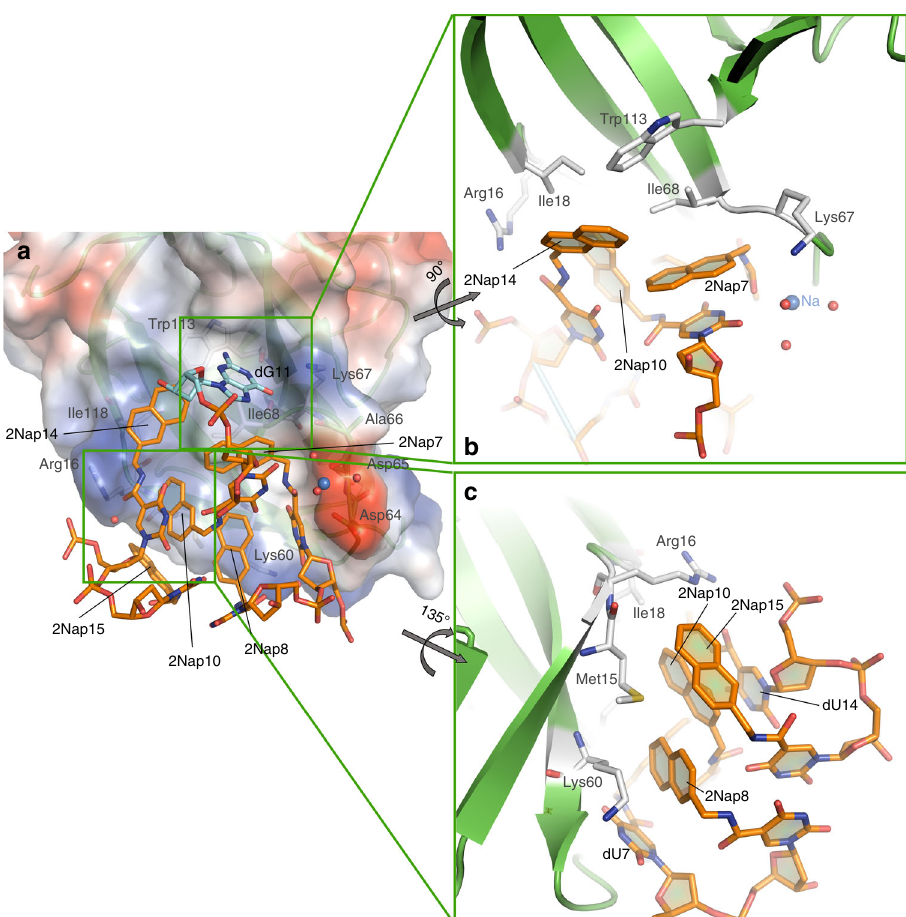
Fig. 4 The hydrophobic interactions along the IL-1 α /SL1067 interface. a The IL-1 α surface is transparent. The SL1067 residues that are evolved in the hydrophobic contacts with IL-1 α are rendered as sticks . b The Ile68 side chain and 2Nap7 form a stacking interaction similar to Ile18 and 2Nap14. c The Met15 side chain forms edge-to-face π interactions with 2Nap10 and 2Nap15, separately. The Arg16 side chain forms edge-to-edge contacts with 2Nap10 and 2Nap15, respectively. Modi fi ed nucleotides are labeled in black and amino acid residues forming the binding interface are labeled in gray throughout. The two gray arrows indicate the direction and degree of rotation for each inset